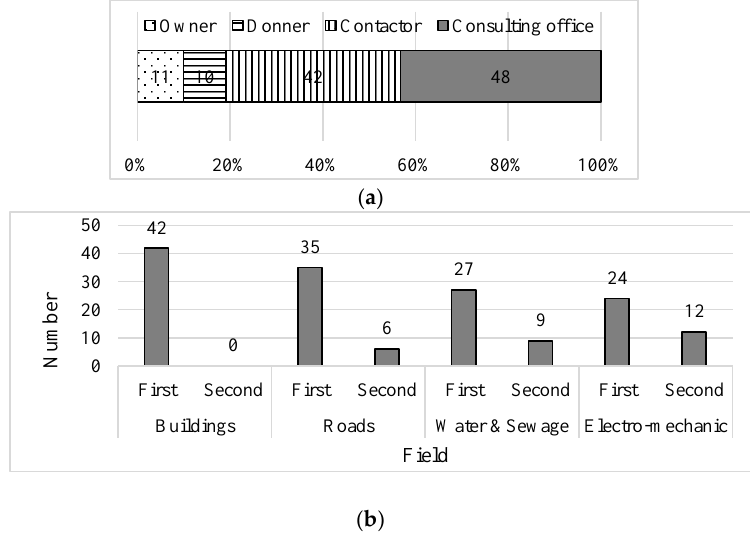
Figure 5. Information about the responding institutions: ( a ) type of establishments and ( b ) fields of contracting companies.